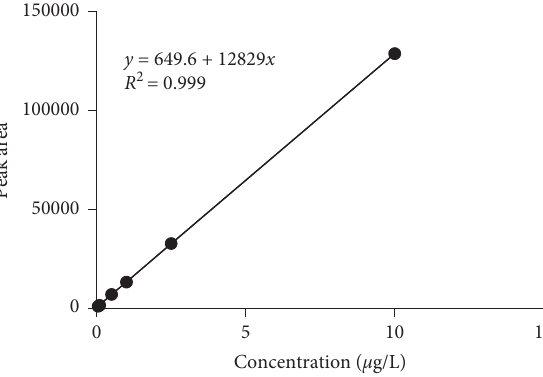
Figure 1: Standard curve of AFM1 contamination. Table 2: AFM1 in different types of milk products determined by